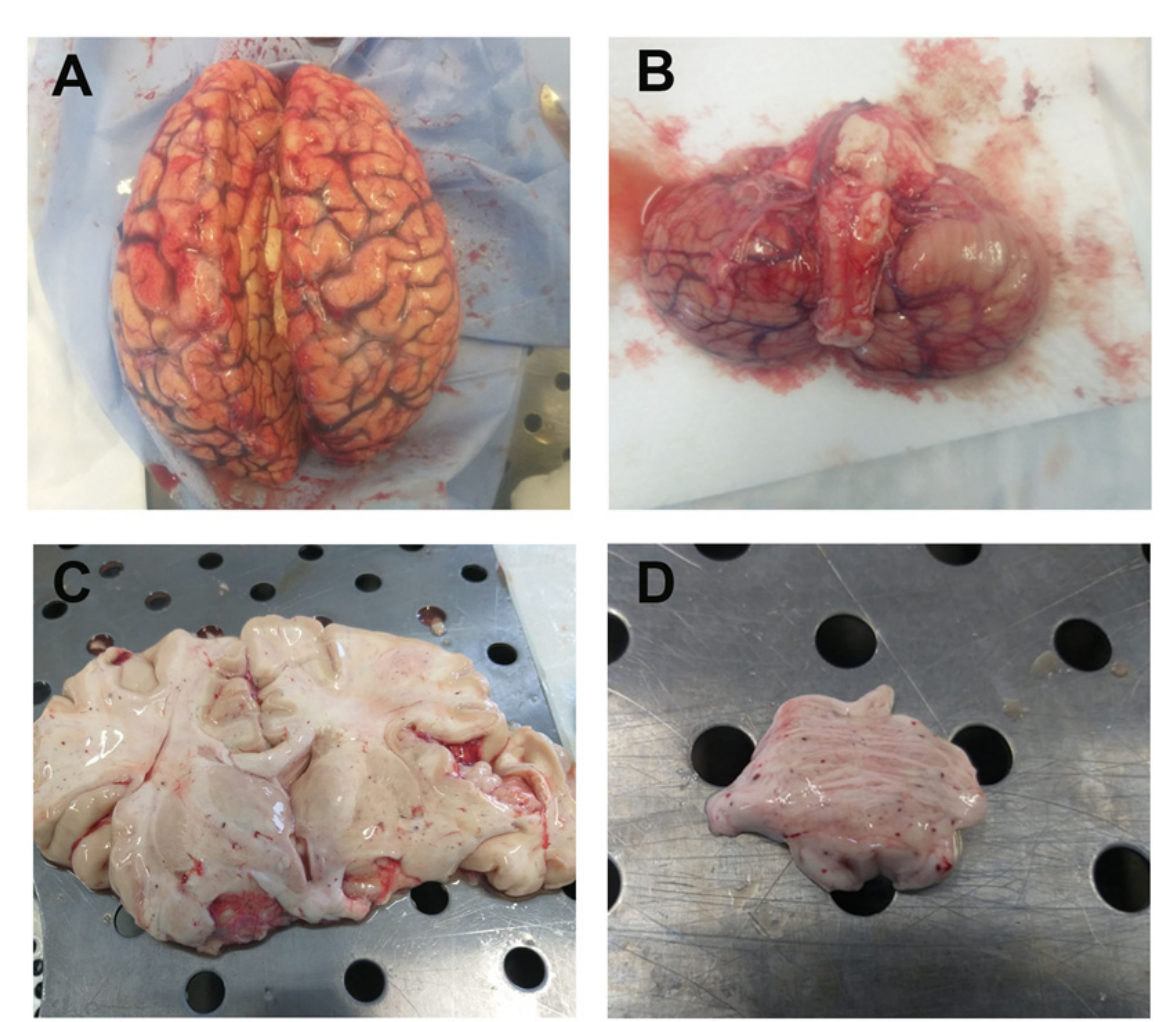
Figure 1. Brain gross anatomy in COVID-19 patients. ( A ) The cerebral hemispheres appear symmetrical, diminished in consistency with hyperemia of leptomeninges. Cerebral cortex parenchymal edema, macroscopically visible because of gyral flattening and compression of the sulci with broadening of perivascular spaces. ( B ) Cerebral cortex trunk in axis, midcerebral cortex and cerebellum free from macroscopically detectable alterations. ( C ) Cerebral cortex section along the coronary plane shows modest atrophy of the cerebral cortex. Shiny white substance in the cerebral cortical and basal nuclei, due to edema and hemorrhagic petechial areas. ( D ) Petechial areas in the pontine region that shows mottled appearance due to the grey discoloration. Images from patients who did not have previous neurological deficits.